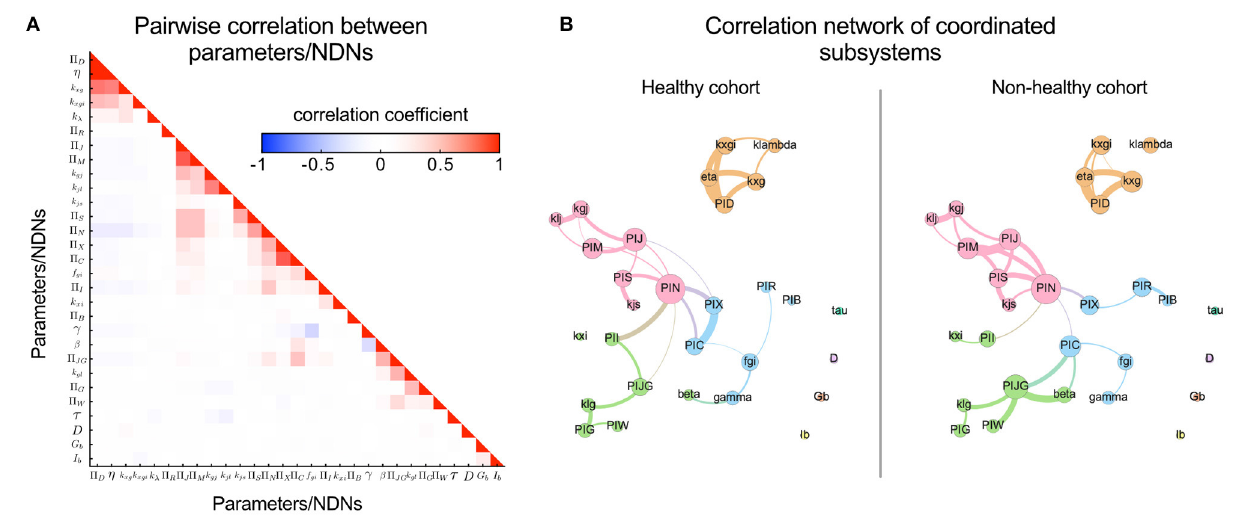
FIGURE 4 | Pairwise correlation visualisation reveals covariating parameters/NDNs and local coordination between subsystems mediated by the incretin potency NDN ( 5 N ). Coordination or independence between parameters can be quantified through their pairwise correlation coefficients; The higher the independence between Parameter/NDN, the lower their correlation coefficient. (A) Heatmap representing pairwise correlation between all model parameters/NDNs obtained for the general cohort. Cells are coloured according to the value of the pairwise correlation coefficient. The low colour saturation in cells indicates a general absence of redundancy between parameters/NDNs. (B) Visualising the correlation between parameters/NDNs in graph representations reveals communities of coordinated subsystems (represented in different colours). Each graph node (coloured circles) represents one parameter/NDN, and the node size is proportional to the number of other parameters/NDNs that are correlated to the node’s parameter/NDN. Graph edges connect correlated parameters/NDNs, and their width is proportional to the absolute value of the correlation coefficient between connected nodes. Independent parameters have no connections between them. Three of these parameters/NDNs communities (pink, green, cyan) are loosely associated, mainly through the central 5 N node, while the fourth community is completely independent from the others (orange). Four parameters are non-correlated, including fasting glycemia and insulinemia, which remarks that basal levels do not directly reflect the health of any internal physiological system by themselves. Parameters/NDNs are more correlated in the non-healthy state, reflecting the loss of degrees of freedom and the strain to achieve glycemic control in non-healthy